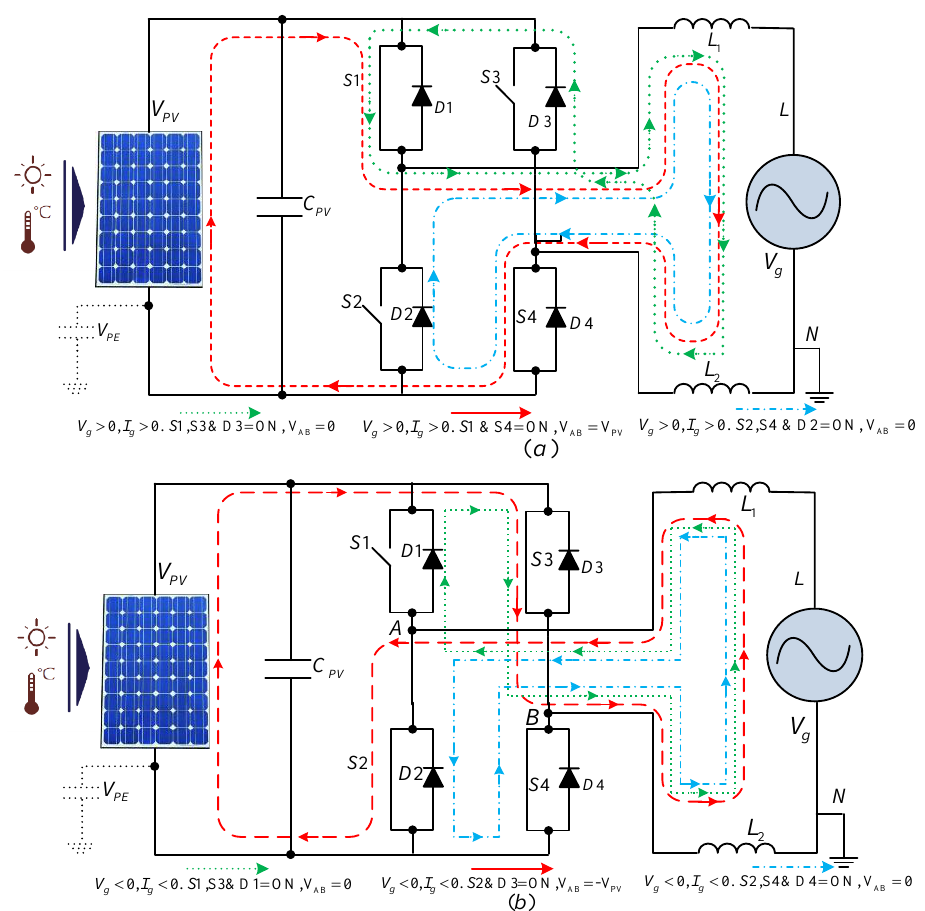
Figure 5. Three-level modulation scheme for FB in case of ( a ) positive cycle and ( b ) negative cycle [29,30].